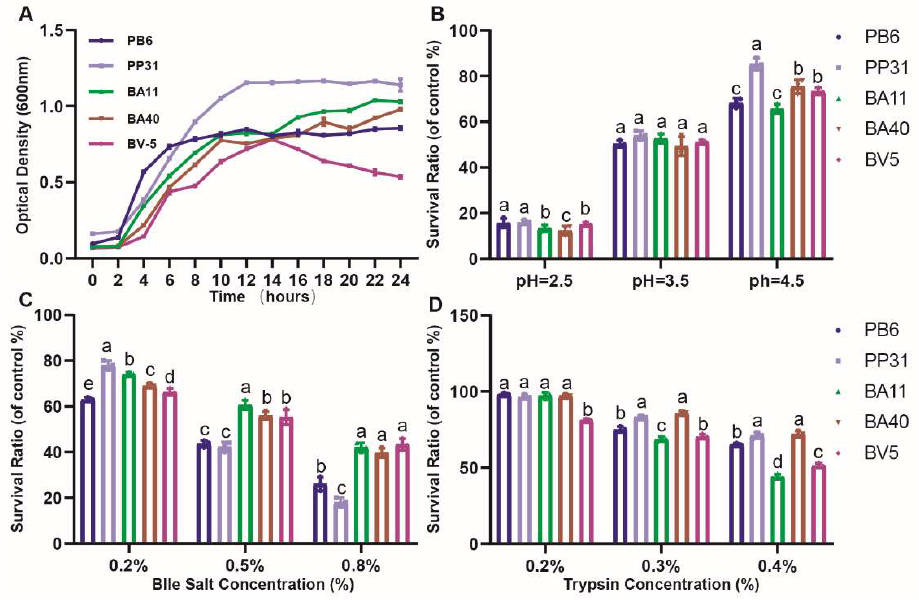
Figure 3. Probiotic properties of isolated strains. ( A ) The growth curves. ( B ) The ability of acid tolerance. ( C ) The ability of bile salt tolerance. ( D ) The ability of trypsin tolerance. a, b, c, d Means values with dissimilar letters were significantly different ( p < 0.05). All values contained three